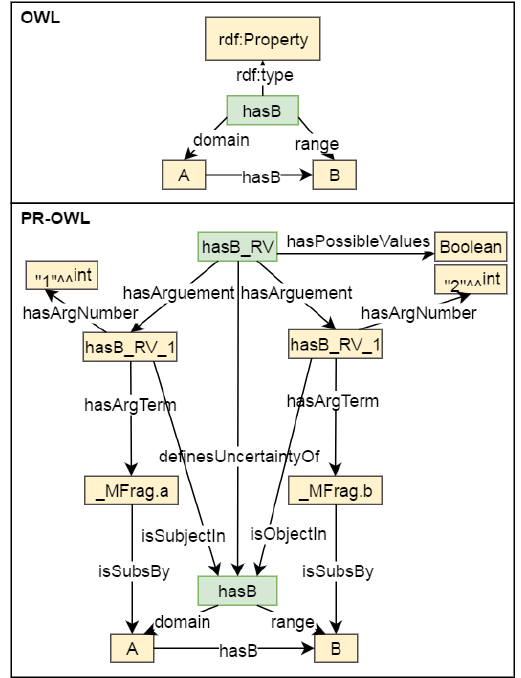
Figure 8. Mapping of PR-OWL random variables and OWL properties.